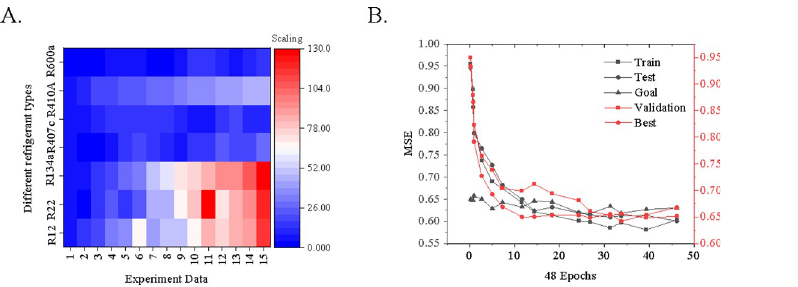
Fig 7. Model performance and errors under different freezing media.